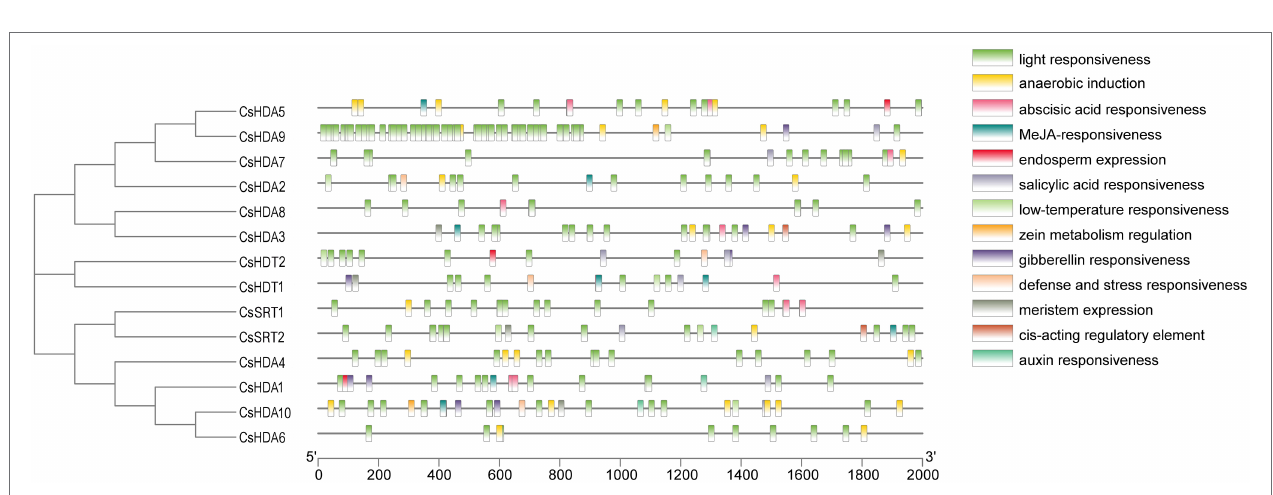
FIGURE 5 | CIS -acting elements of the CsHDAC